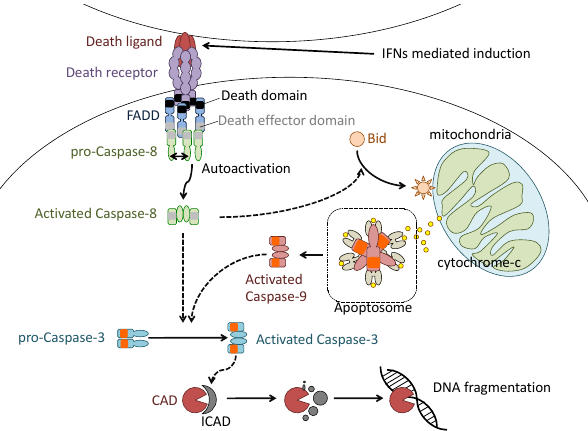
Figure 2. Molecular defined apoptosis induction in influenza virus infection. Type-I IFN-mediated death ligand expression on the host cell surface aggregates death receptor (DR)